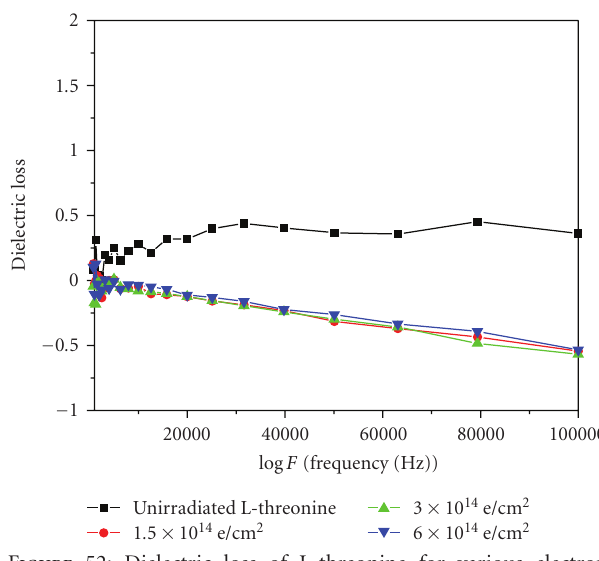
Figure 52: Dielectric loss of L-threonine for various electron